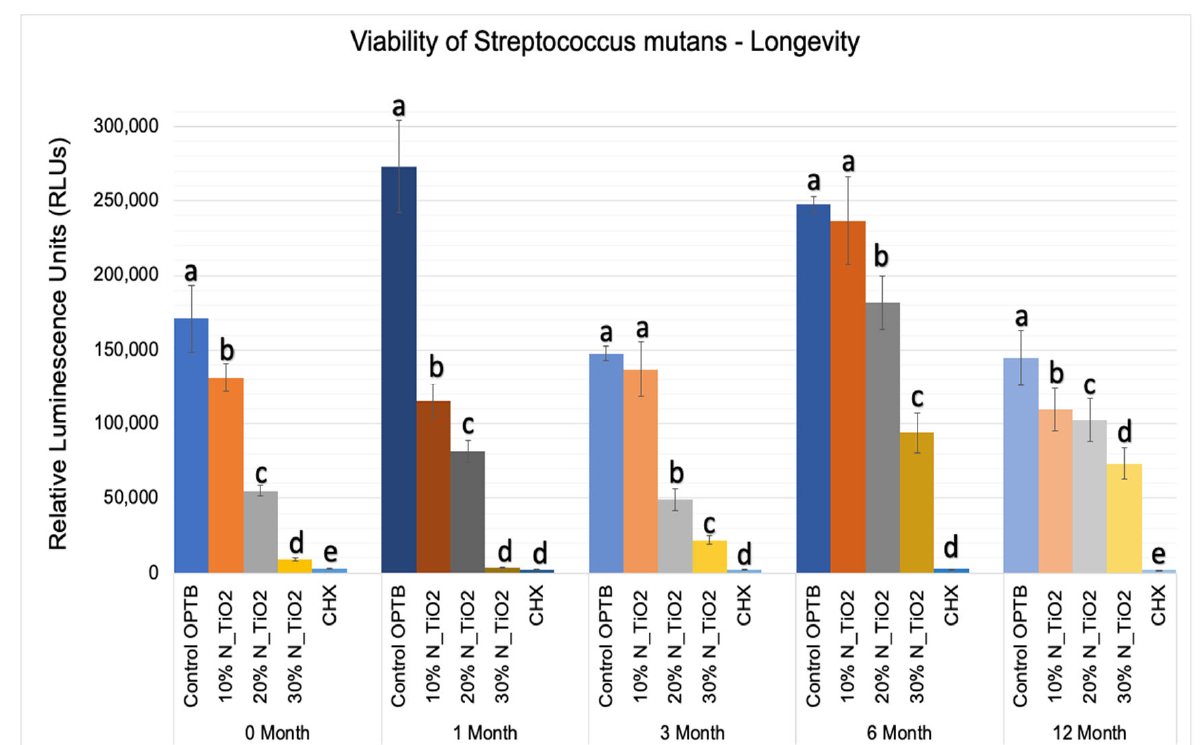
Figure 7. Expression of luciferase activity ( n = 18/group) was quantified in terms of bioluminescence. Biofilms grown on specimens of dental adhesives that were then aged for 0, 1, 3, 6, and 12 moths in PBS exhibited lower bioluminescent values when exposed to higher nanoparticle concentrations. Letters above bars illuastrate the SNK rankings and denote mean values that are statistically different ( p < 0.001) within timepoints of 0, 1, 3, 6, and 12 months.